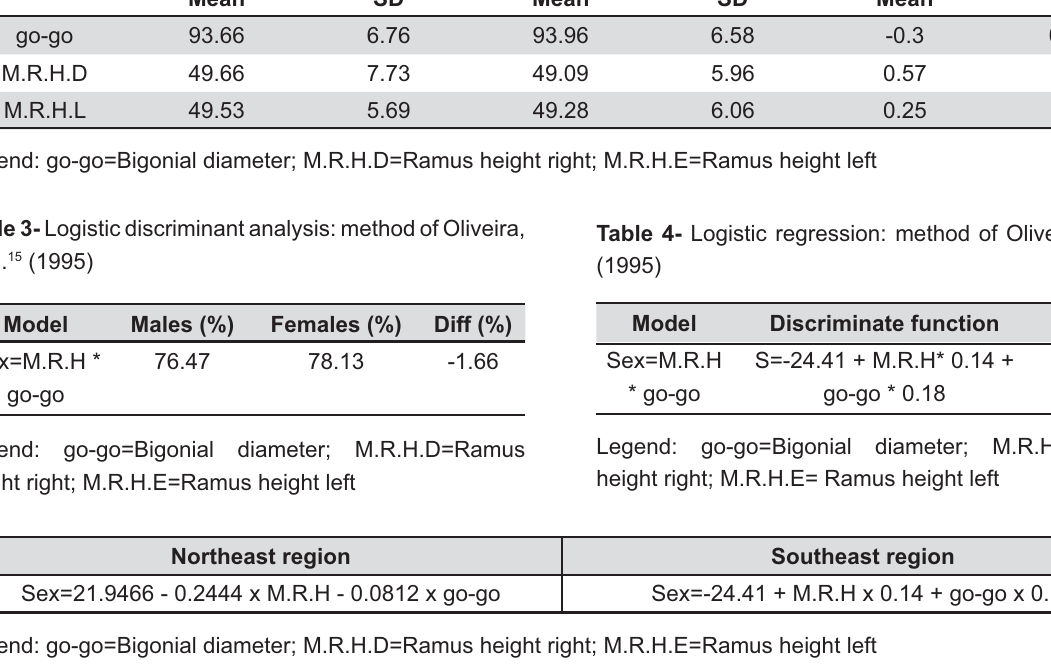
Table 2- Distribution of quantitative variables (N=32) according to the paired t-test to verify the reliability inter-examiner